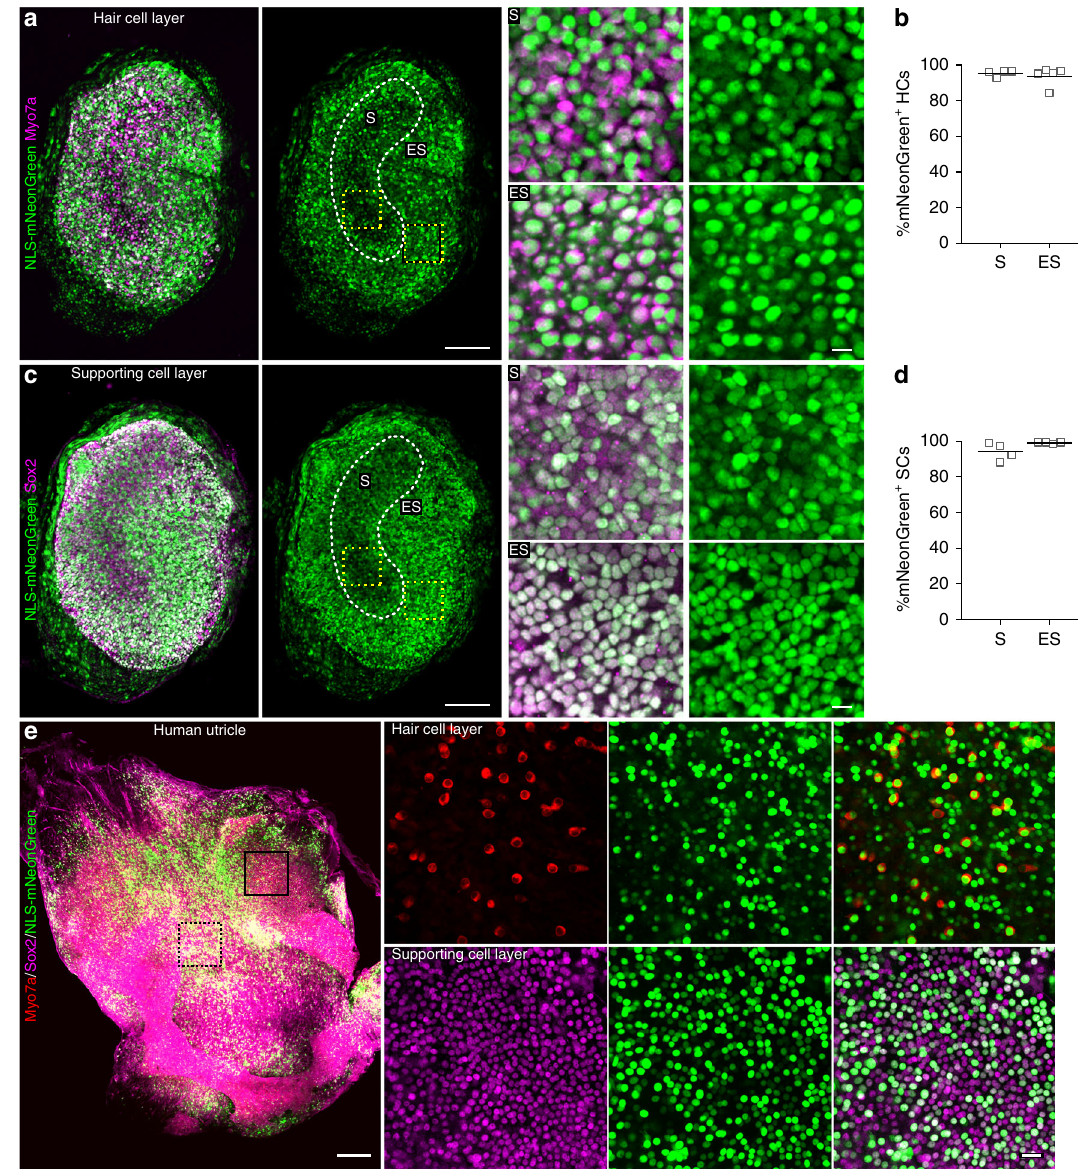
Fig. 3 Adeno-associated virus-inner ear (AAV-ie) transduction in vestibular sensory epithelia. a – d Mouse utricle from a P3 mouse injected with AAV-ie- NLS-mNeonGreen (nuclear localization sequence-mNeonGreen) (1 × 10 10 genome-containing (particles) (GCs) per ear). The tissues were harvested at P17 fi xed and stained with anti-Myo7a antibody ( a , magenta) or anti-Sox2 antibody ( c , magenta) and imaged for mNeonGreen fl uorescence (green). a , Left, representative confocal images of stained mouse utricular hair cells. Scale bar, 100 µ m. Right, magni fi ed regions from left yellow boxes. Scale bar, 10 µ m. Green: NLS-mNeonGreen; magenta: Myo7a. S and ES indicate the striolar region and extrastriolar region, respectively. b Percentage of NLS-mNeonGreen- positive utricular hair cells in S and ES regions. Horizontal bars represent mean values. N = 5 mice. Source data are provided as a Source Data fi le. c , d Same as a , b except that utricular supporting cells were captured and analyzed. Horizontal bars represent mean values. N = 4 mice. Source data are provided as a Source Data fi le. e , Left, The sensory epithelium of an adult human utricle. The tissue was exposed to 5 × 10 10 GCs AAV-ie-NLS-mNeonGreen for 24 h, cultured for 7 days, fi xed, stained with anti-Myo7a antibody (red) or anti-Sox2 antibody (magenta), and imaged for mNeonGreen fl uorescence (green). Scale bar, 250 µ m. Right, magni fi ed regions from human utricle in hair cell layer and supporting cell layer. Scale bar, 20 µ